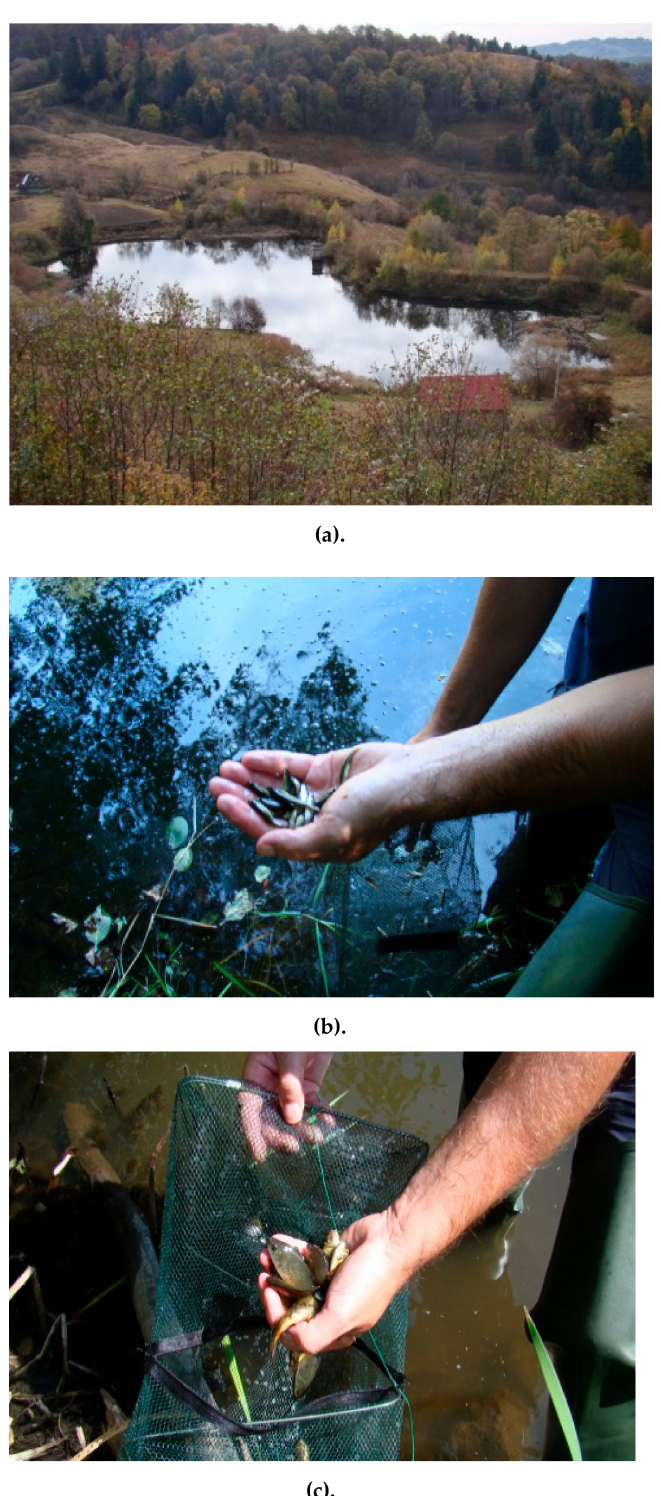
Figure 2. ( a ). Corna Lake, a permanent source of organic matter for the Corna Valley. ( b ). Pseudorasb- ora parva individuals sampled in Corna Lake. ( c ). Carassius auratus gibelio individuals sampled in Corna